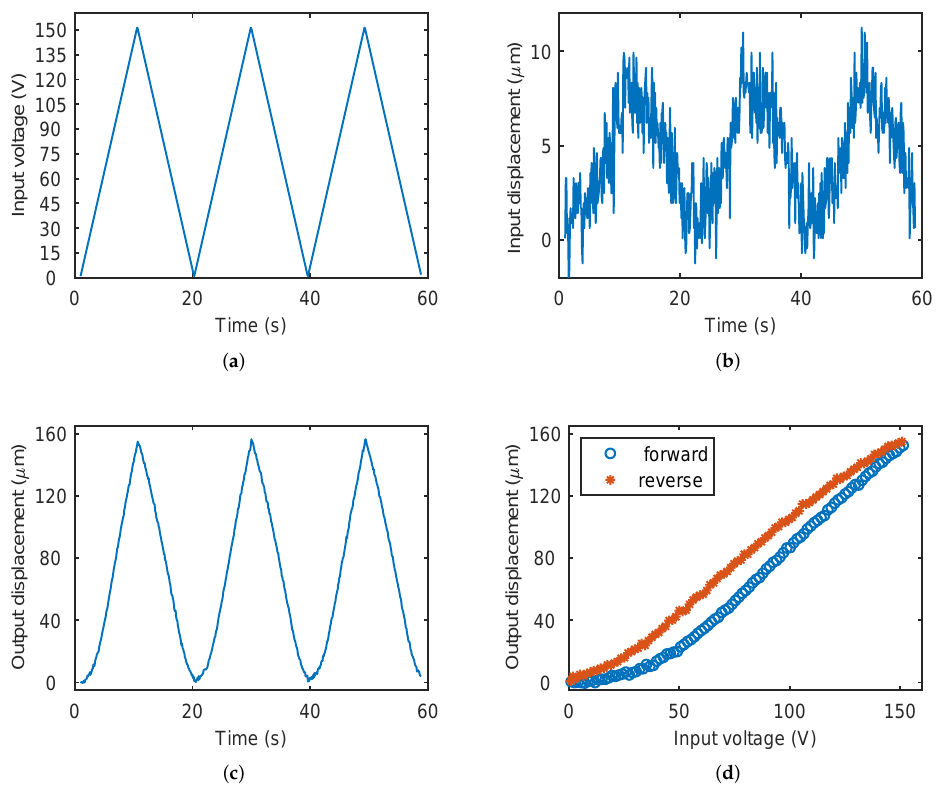
Figure 10. Experimental results of gripping displacement test. ( a ) Input voltage, ( b ) input displace- ment, ( c ) output displacement, and ( d ) output displacement versus input